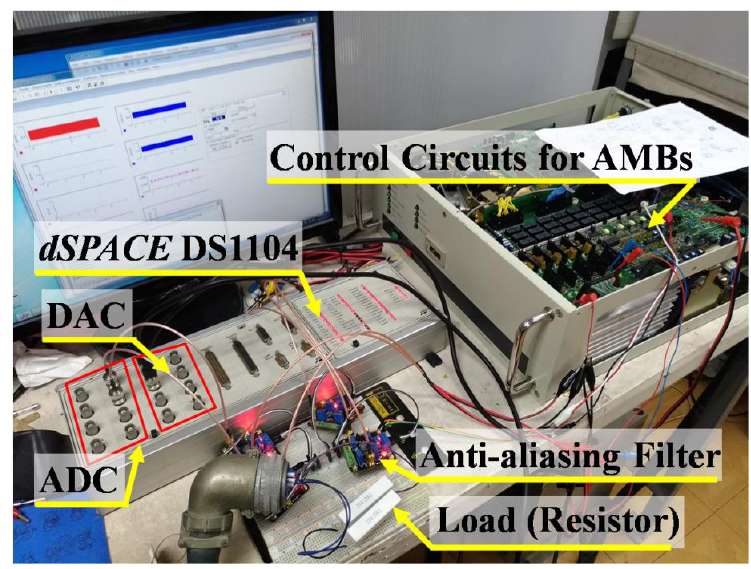
Figure 6. Test rig of system identification on the controller.